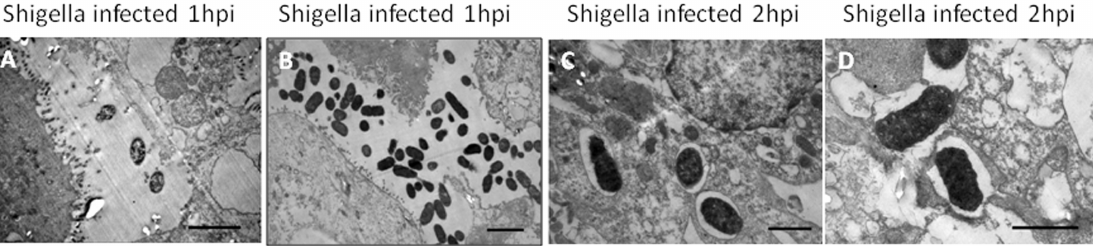
Figure 7. Transmission electron microscopy of the primary chicken intestinal epithelial cells infected with the Shigella strain ZD02. Uninternalized bacteria were seen near the epithelial cells at 1 h post-inoculation (A, B. Scale bars=2 m m). The internalized bacteria were encapsulated with phagosome-like membranes (C, D. Scale bars=1 m m).